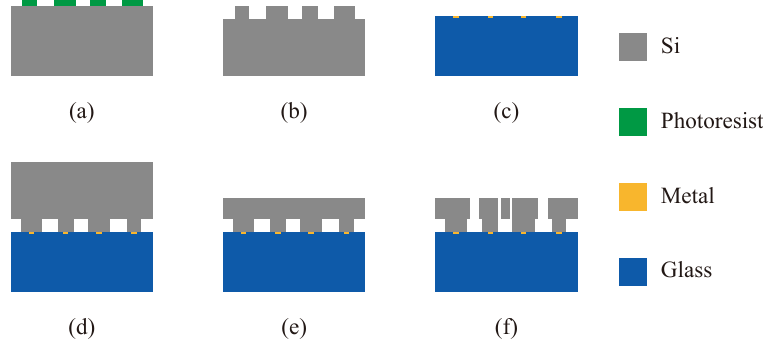
Figure 6. The fabrication process of VRG: ( a ) Photo-etching, ( b ) Bonding area etching, ( c ) Metal deposition, ( d ) Anodic bonding, ( e ) Thinning and polishing, ( f ) Dry etching and structure